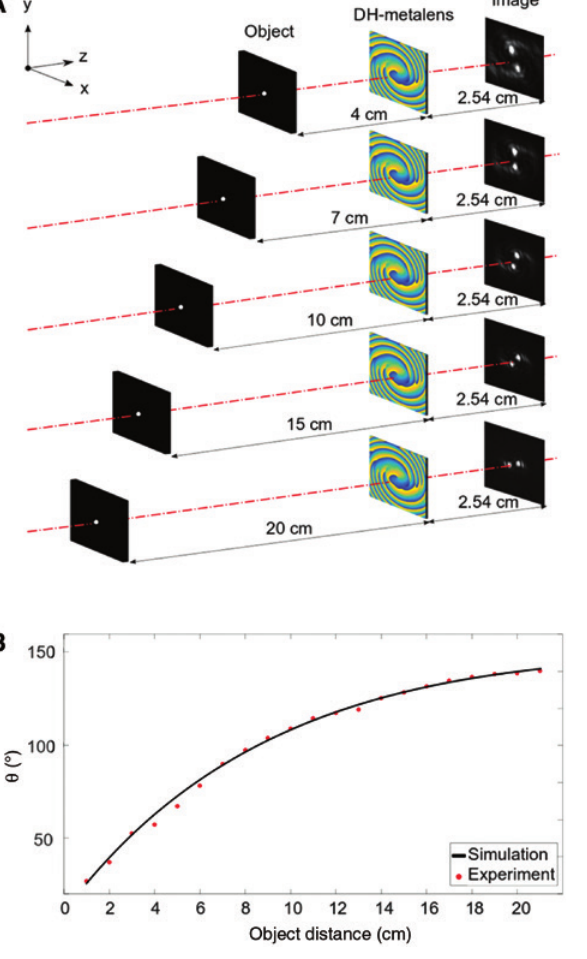
Figure 4: Experimental imaging of a moving microhole. (A) Images of an on-axis point source (microhole) moving along the optical axis by fixing the imaging distance at 2.54 cm, i.e. at the focal plane of the DH-metalens. Images for five object distances are shown. (B) Theoretically calculated and experimentally obtained rotation angle ( θ ) in the image as a function of the object distance.